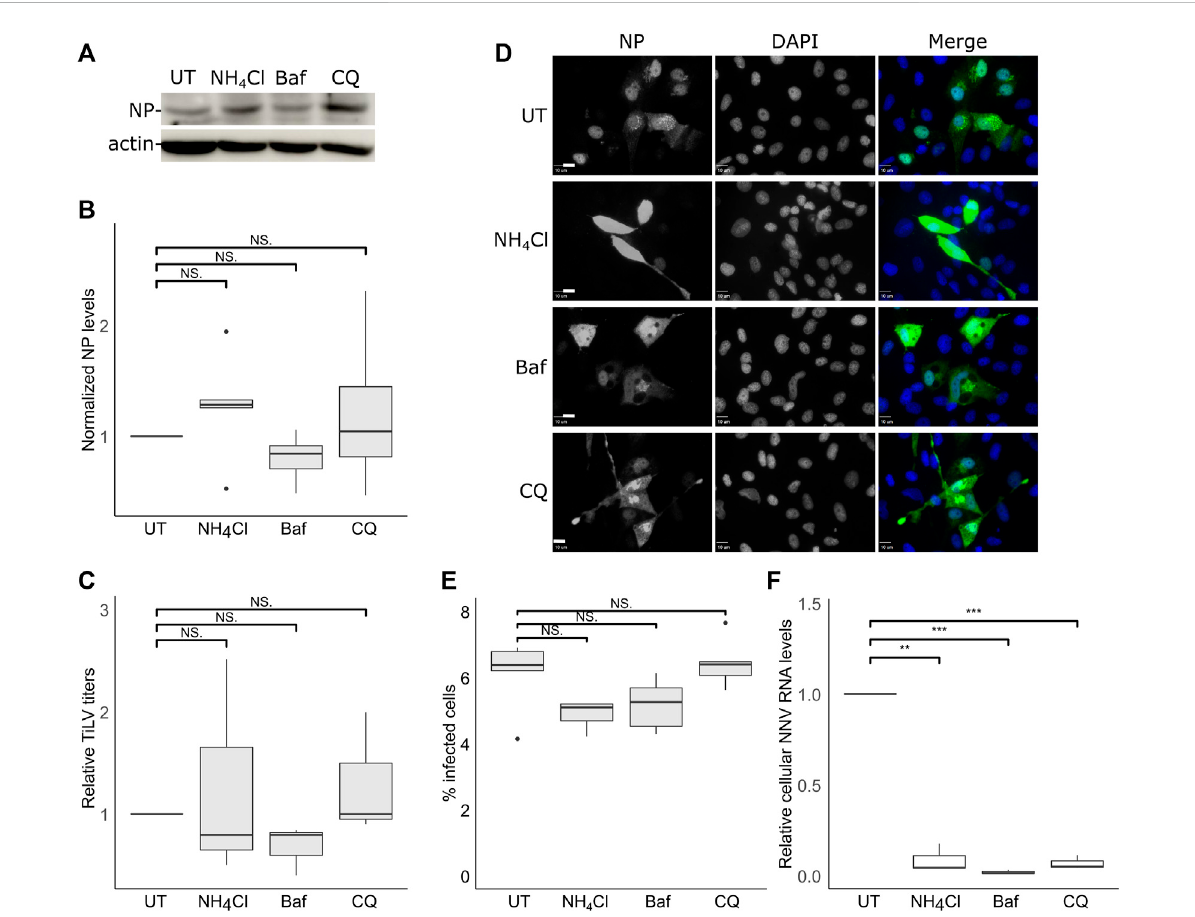
TiLV entry is independent of endosomal acidi fi cation. (A – E) TmB cells were treated and infected with TiLV as described in Figure 2A, with the followingmodi fi cation:infectedcultureswereincubatedwith thedrugsforanadditional24 haftertheentrywindow. (A) Immunoblotting ofcellular NP and actin of a representative experiment of untreated (UT) TiLV-infected TmB cells, or treated with NH 4 Cl, Ba fi lomycin A1 (Baf), or chloroquine (CQ). (B,C) Boxplots of measurements of three independent experiments for each indicated drug. (B) Normalized NP levels (calculated as in Figure 2C). (C) Relative TiLV titers (calculated as in Figure 2D). (D) Immuno fl uorescence microscopy of TiLV-infected TmB cells at 24 h post the end of the entry window. Cells stained with anti-NP antibodies and DAPI were imaged with a confocal microscope. Bars represent 10 μ m. (E) Cells, as described in (D) ,wereimagedatlow magni fi cationto calculate thepercentage ofNP-positivecells. Thetotalnumberofcells wasdeduced fromthe DAPIstaining.Theboxplotdepictsthepercentageofinfectedcellsfrom fi veimage fi elds(~5000cells)percondition. (F) Quanti fi cation(byqRT-PCR) ofcellularNNVRNAlevelsininfectedE-11cells.Theboxplotshowsmeasurementsofthreeindependentexperimentsforeachindicateddrug.**, p ≤ 0.01; ***, p ≤ 0.001; NS, non-signi fi